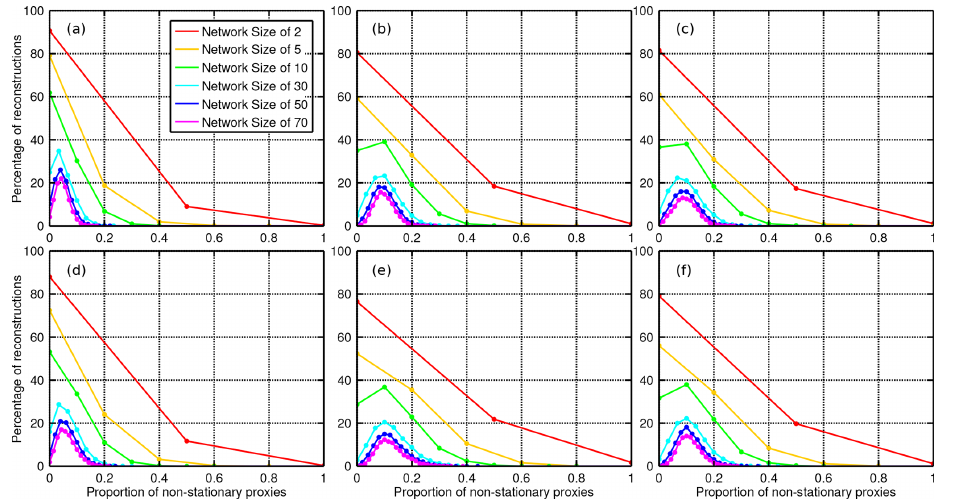
Figure A1. The chance of creating a SAM reconstruction ( y axis) with a certain proportion of non-stationary proxies ( x axis), as calculated from 10000 reconstructions for each network size. Panels show the probabilities for 31 year (a, d) , 61 year (b, e) , and 91 year (c, f) calibration windows. Panels (a) – (c) and (d) – (f) show reconstructions based on SAT and precipitation data, respectively.